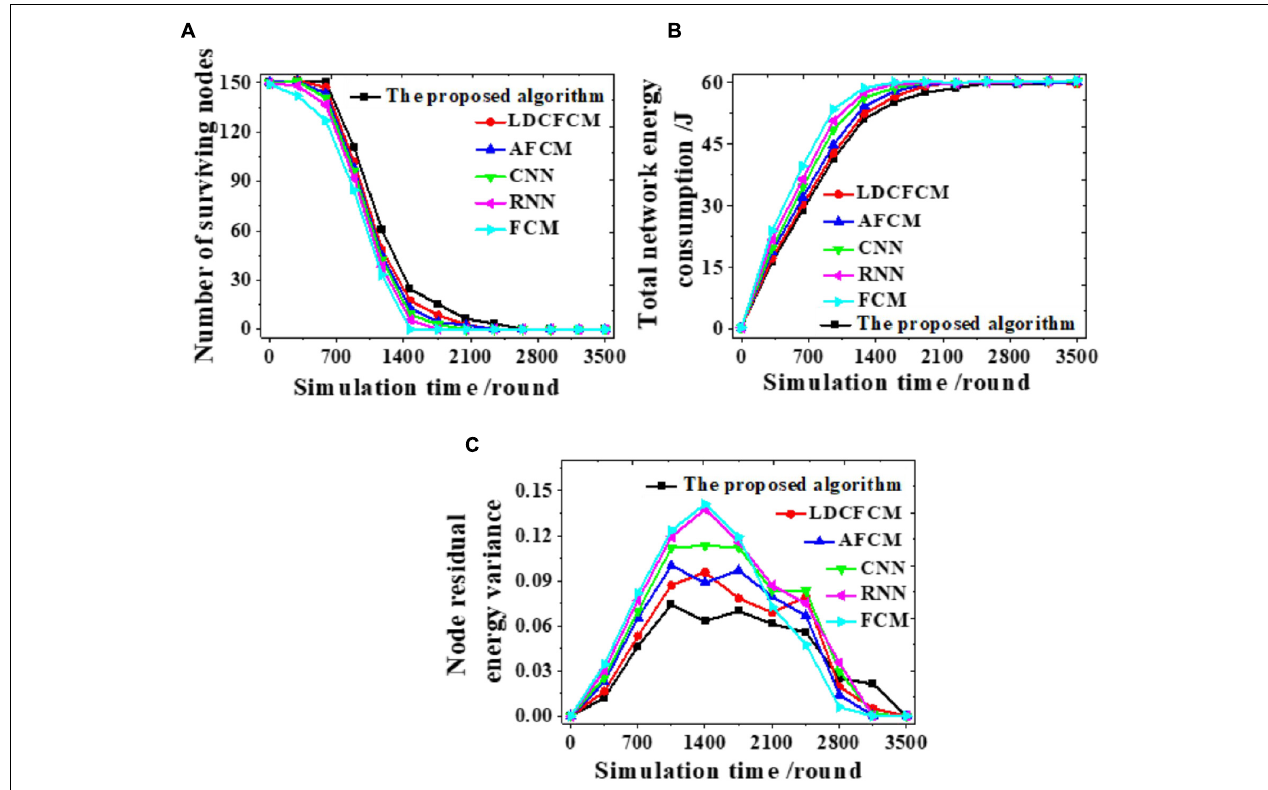
FIGURE 6 | The number of nodes surviving, the total energy consumption of the network, and the node remaining energy variance during the clustering process. (A) The number of nodes surviving. (B) The total energy consumption of the network. (C) The remaining energy variance of the